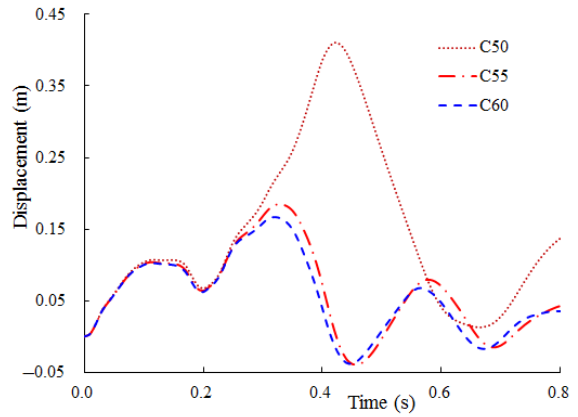
Figure 11. Max displacement time-history of containment.